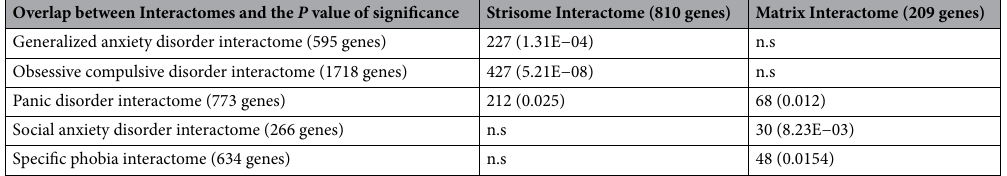
Table 1. Overlap of the anxiety disorder and striatal subcompartment interactomes. The table shows the statistics of the overlaps shared between the five anxiety disorder interactomes and the interactomes of the striatal